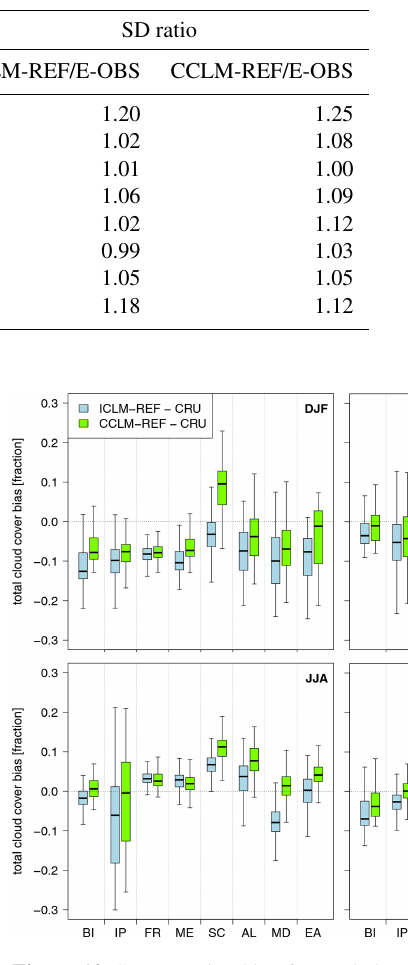
Figure 9. Same as Fig. 5 but for MSLP.